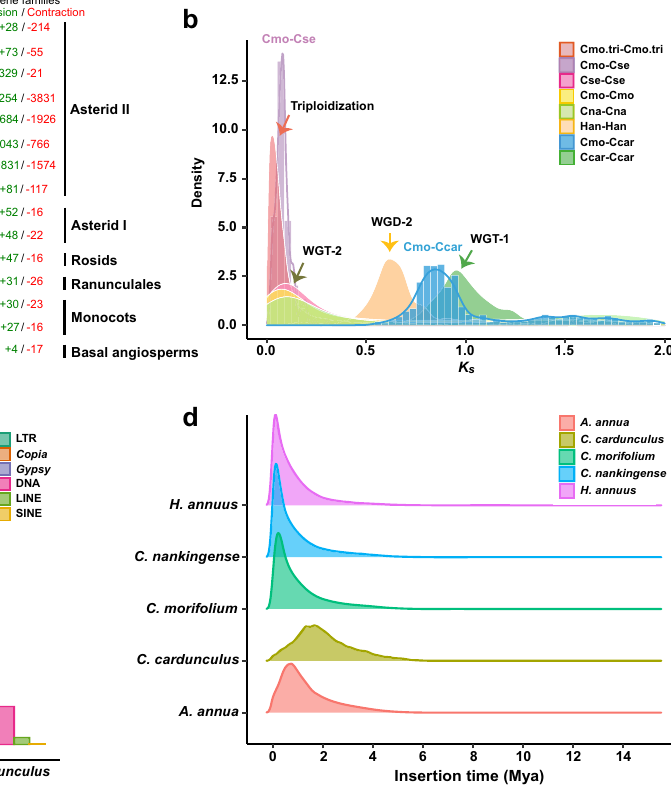
95%con fi denceintervalsofthedivergencetimebetweendifferentclades.TheWGD and WGT events are marked with coloured dots. b Ks distribution of syntenic paralogues found within C. morifolium and fi ve other Asteraceae sequenced spe- cies. The polyploidization events are referenced on the peaks. c Comparison of repetitivesequencesamong C.morifolium and C.nankingense , A.annua , H.annuus , C.cardunculus . d Insertion time distributions of intact LTRsindifferentAsteraceae species. Source data are provided as a Source Data fi